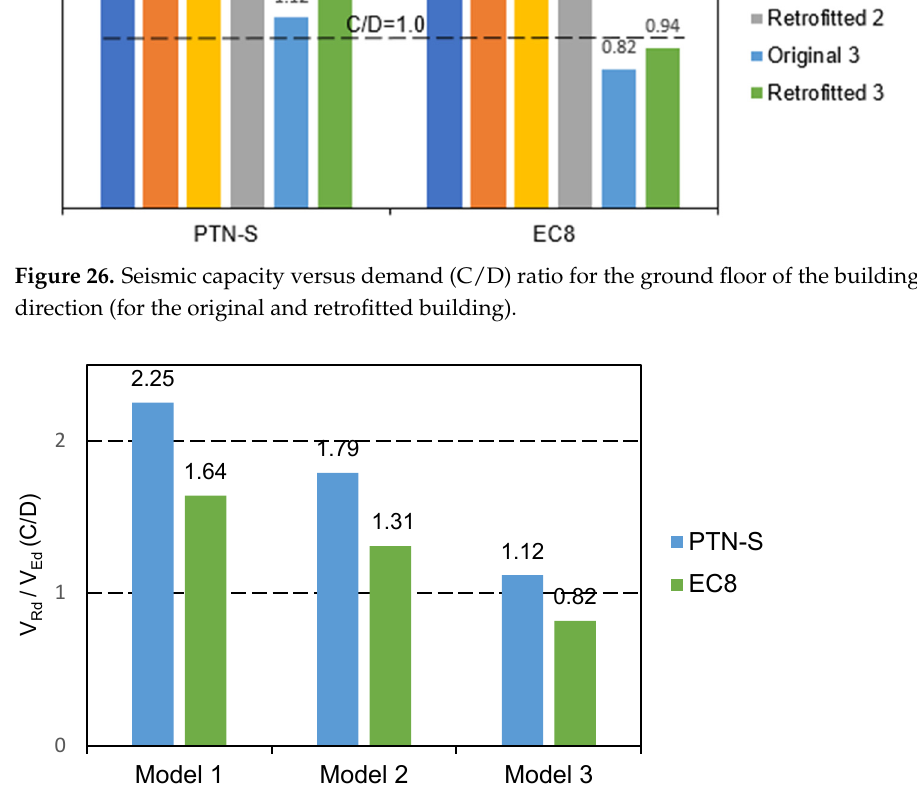
Figure 27. Seismic capacity versus demand (C/D) ratio for the ground floor of the building in E–W direction (for the original building).